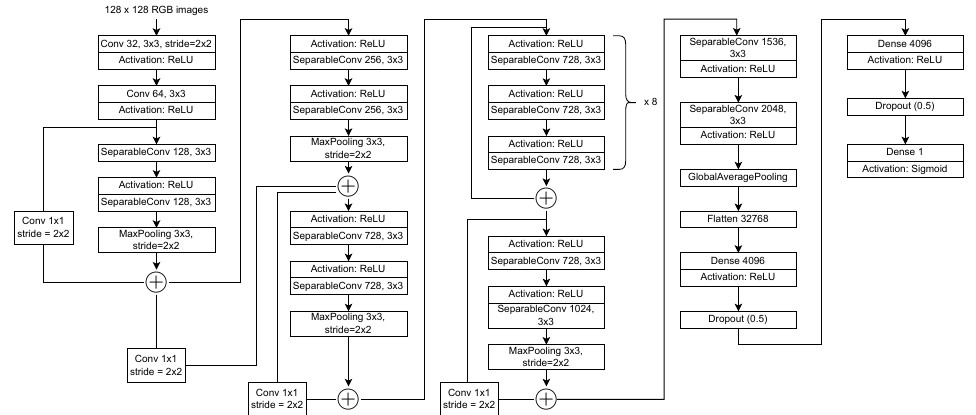
Figure 4. Xception ImageNet pre-trained model with transfer